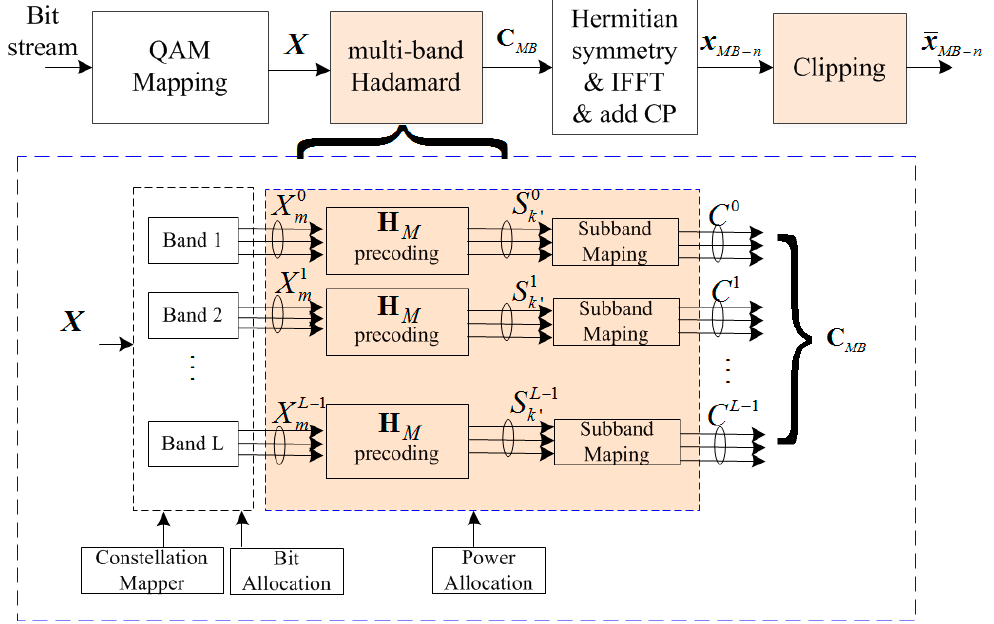
Figure 2. Diagram of the proposed scheme at transmitter.